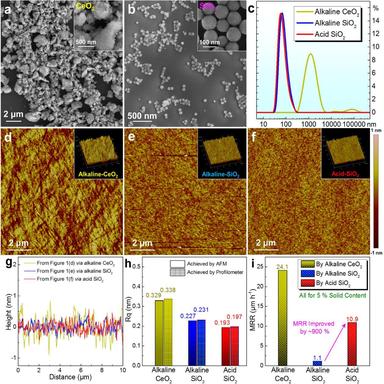
Characterization of polishing abrasives and their CMP results. SEM images of (a) CeO2 and (b) SiO2 abrasives with corresponding magnified SEM images inset; (c) comparison of the size distribution curves of CeO2 in alkaline slurry and SiO2 in both alkaline and acid slurries; AFM images with the corresponding 3D images (inset) of the FS wafer surface after polishing by (d) alkaline CeO2 slurry, (e) alkaline SiO2 slurry, and (f) acid SiO2 slurry; comparisons of (g) section lines taken from parts (d-f), (h) Rq,